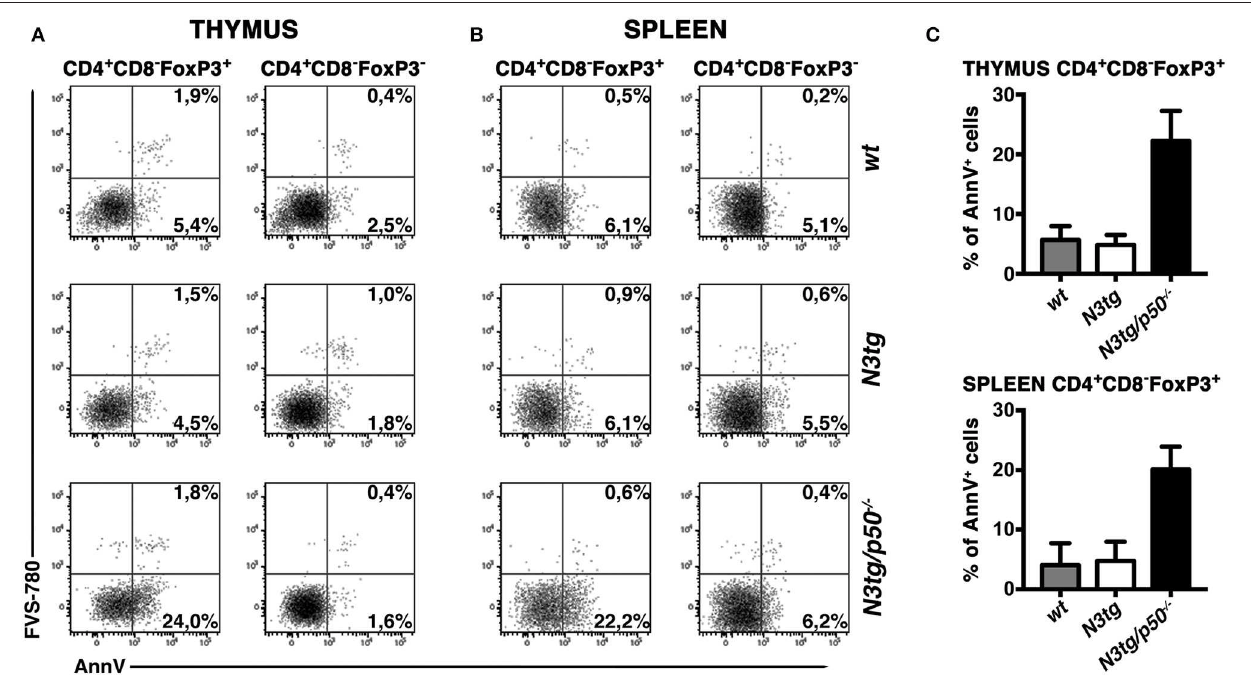
FIGURE 10 | Tregs from N3tg/p50 − / − double-mutant mice show enhanced apoptosis. Representative dot plots of FVS-780/Annexin V distributions inside gated CD4 + CD8 − Foxp3 + Tregs or gated CD4 + CD8 − Foxp3 − cells, from thymus (A) and spleen (B) of N3tg/p50 − / − , N3tg, and wt mice at 4–5 weeks of age. Percentages of both FVS-780 − Annexin V + early apoptotic cells and FVS-780 + Annexin V + late apoptotic cells are indicated. (C) The graph illustrates the percentages of Annexin V + cells inside CD4 + CD8 − Foxp3 + Tregs from thymus ( upper panel ) and spleen ( lower panel ) of N3tg/p50 − / − , N3tg , and wt mice at 4–5 weeks of age. The values are presented as mean ± SD of two independent experiments ( n = 2 mice per